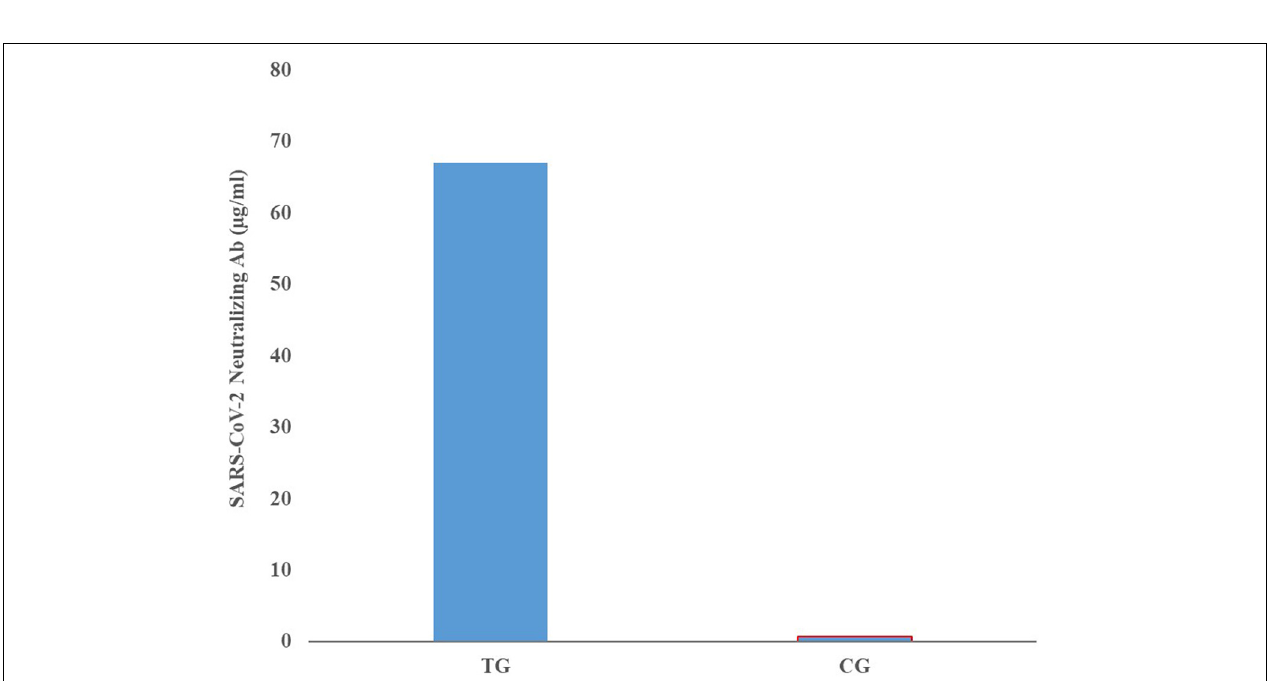
FIGURE 4 | Mean neutralizing antibody titers in the colostrum samples of inoculated and control groups.